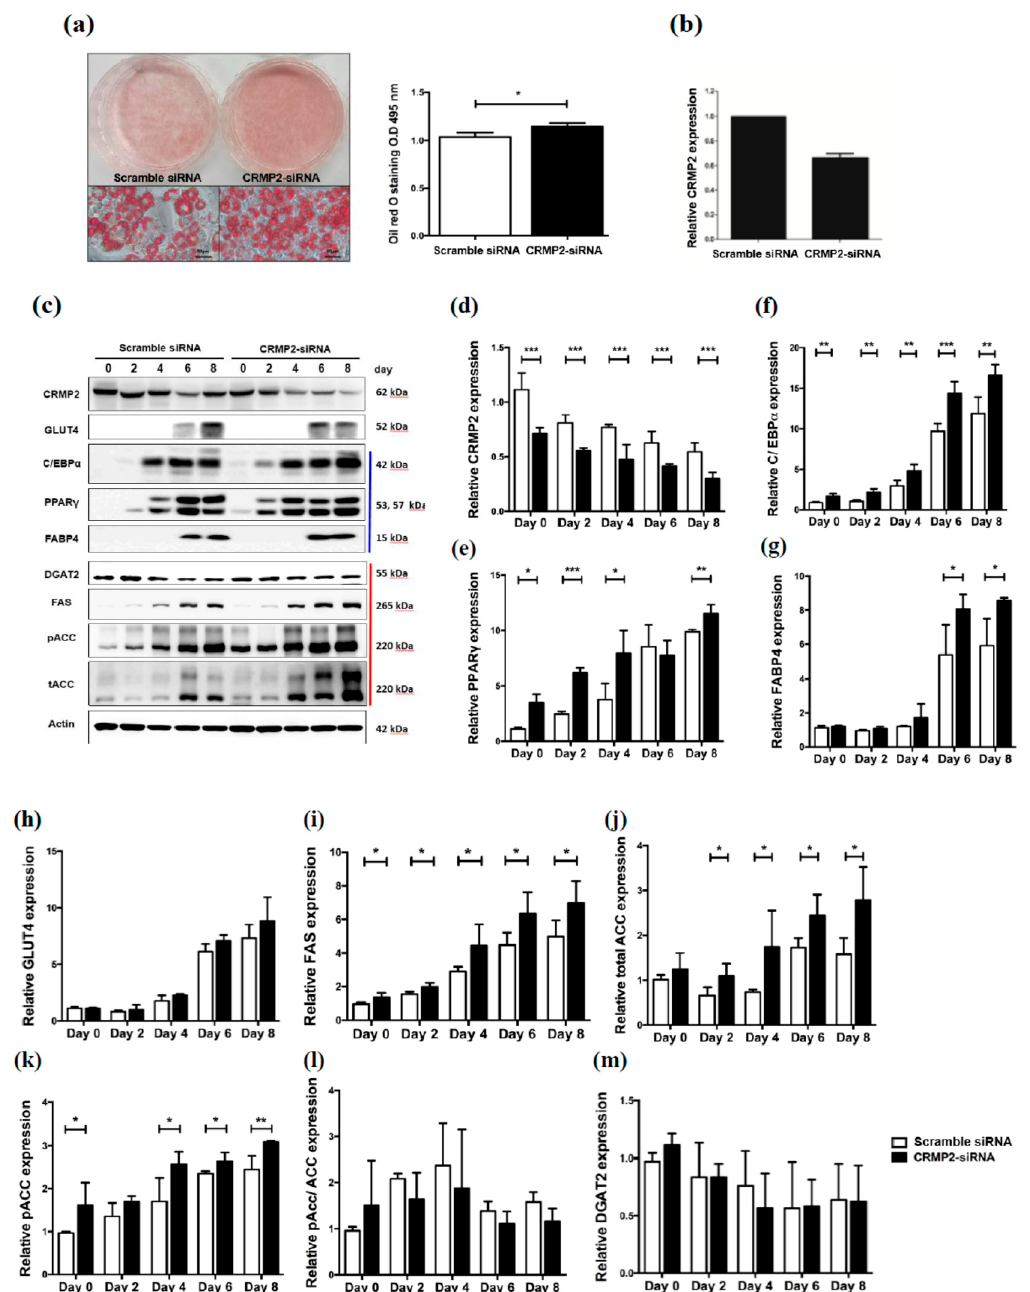
Figure 5. CRMP2 knockdown reverses the inhibitory effects on adipogenesis. Cells were transfected with CRMP2-specific siRNA (CRMP2-siRNA cells) or scramble siRNA on day-2, then subjected to differentiation. ( a ) Lipid accumulation in the mature adipocytes was measured and quantified as described, scale bars = 50 µ m. Expression of CRMP2 RNA ( b ) and protein levels of CRMP2, PPAR γ , C/EBP α , GLUT4 and FABP4 and critical lipid-synthesizing enzymes ( c – m ) were analyzed as the day indicated, with actin as an internal control. Blue and red line at the right of panel ( b ) indicated proteins related to adipogenesis and lipid synthesis, respectively. The data were presented as the mean ± SEM, and statistically analyzed by one-tailed unpaired Student t- test ( n = 3). * p < 0.05; ** p < 0.01; *** p < 0.005.